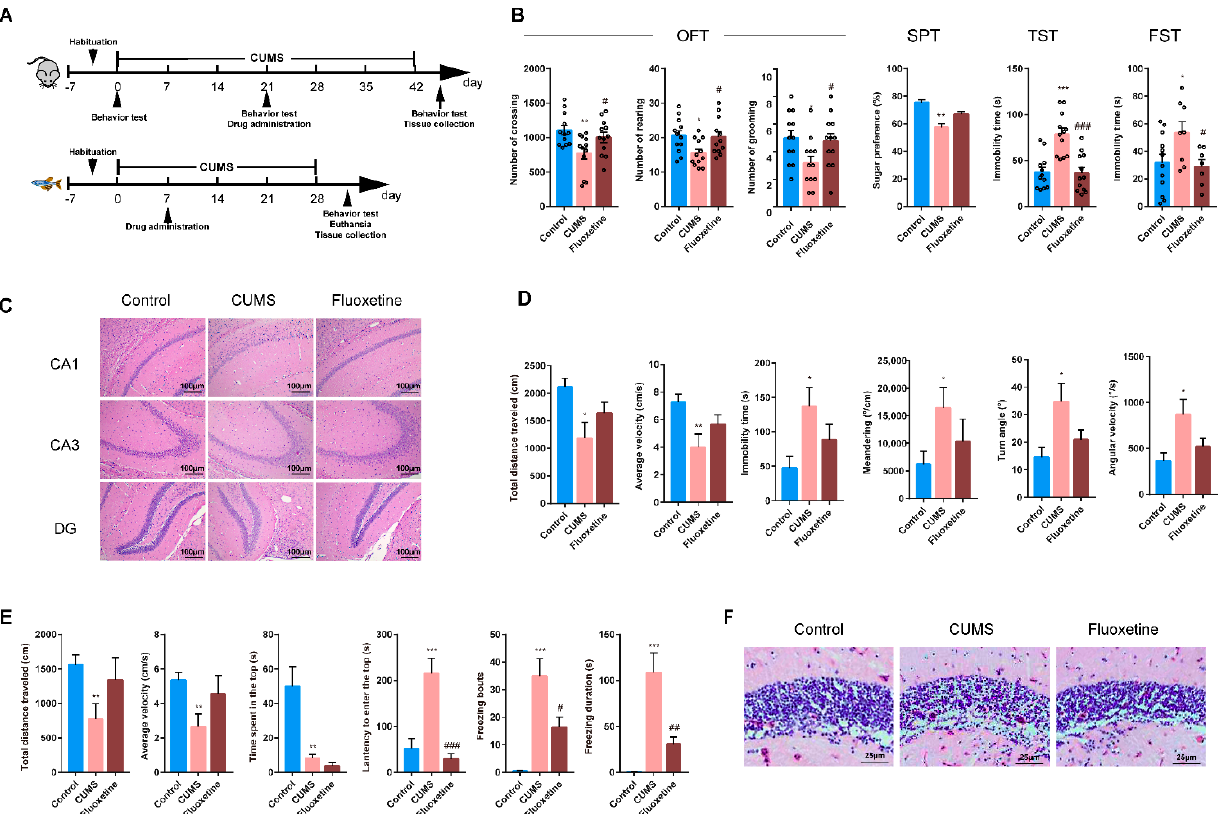
Figure 1. Experimental design and effect of CUMS on mice and zebrafish. ( A ) Experimental design for CUMS. ( B ) The results of behavioral tests for OPT, SPT, FST and TST of CUMS mice. The round symbols indicate data distribution. ( C ) Histopathological observation on mice hippocampus, 100×. ( D , E ) The results of behavioral tests for OFT and NTT of CUMS zebrafish. ( F ) Histopathological observations on adult zebrafish brain, 200×. Data are represented as mean ± SEM. * p < 0.05, ** p < 0.01, *** p < 0.001, compared with control; # p < 0.05, ## p < 0.01, ### p < 0.001, compared with CUMS.